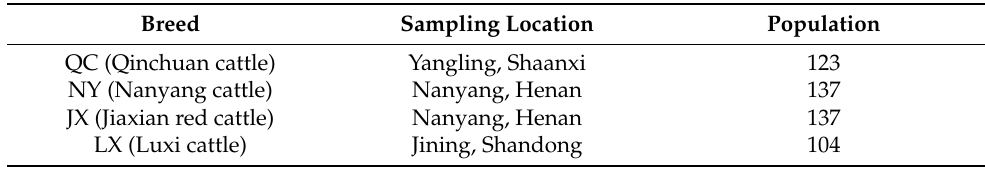
Table 1. Information on samples used in this